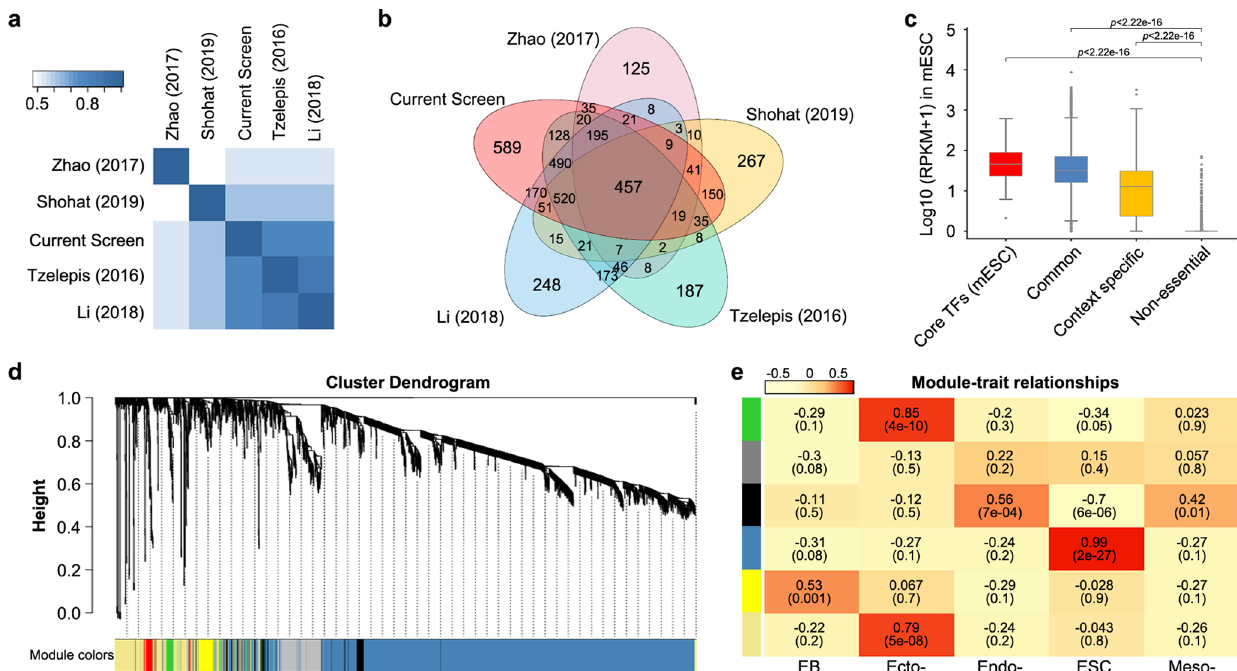
Fig. 2 Comparing and integrating the data of other screens. a Heatmap of Pearson correlation coef fi cients among all pairs of screens. b Venn diagram depicting the comparison of different screening studies with normalized data. The 457 overlapping genes were de fi ned as the common set, whereas all the other genes were de fi ned as the context-speci fi c set (Supplementary Data 5). c Expression levels of the “ core TFs ” , “ common ” , “ context-speci fi c ” and “ non-essential genes ” in mESCs. The data are represented as log + 1). d Cluster dendrogram and module assignment for modules from WGCNA. 10 (RPKM Common and context-speci fi c genes were clustered based on a topological overlap matrix (TOM). The branches correspond to modules of highly interconnected groups of genes. Colours in the horizontal bar represent the modules. Six modules with 3303 genes were detected. e Heatmap of the relationships between the modules and samples. Colours in the longitudinal bar represent the modules. The red cells correspond to positive correlation. The yellow cells correspond to negative correlation. The numbers in the cell indicate the correlation coef fi cient (upper) and p -value (below). Colour intensity is proportional to the correlation coef fi